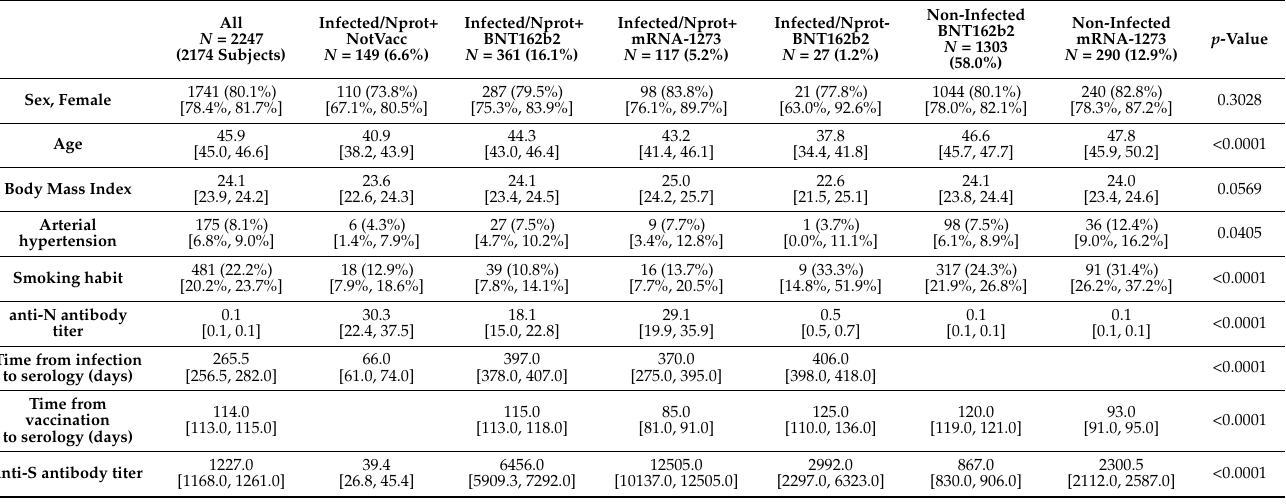
Table 1. Demographic and clinical characteristics of subjects in the study according to infection and vaccination